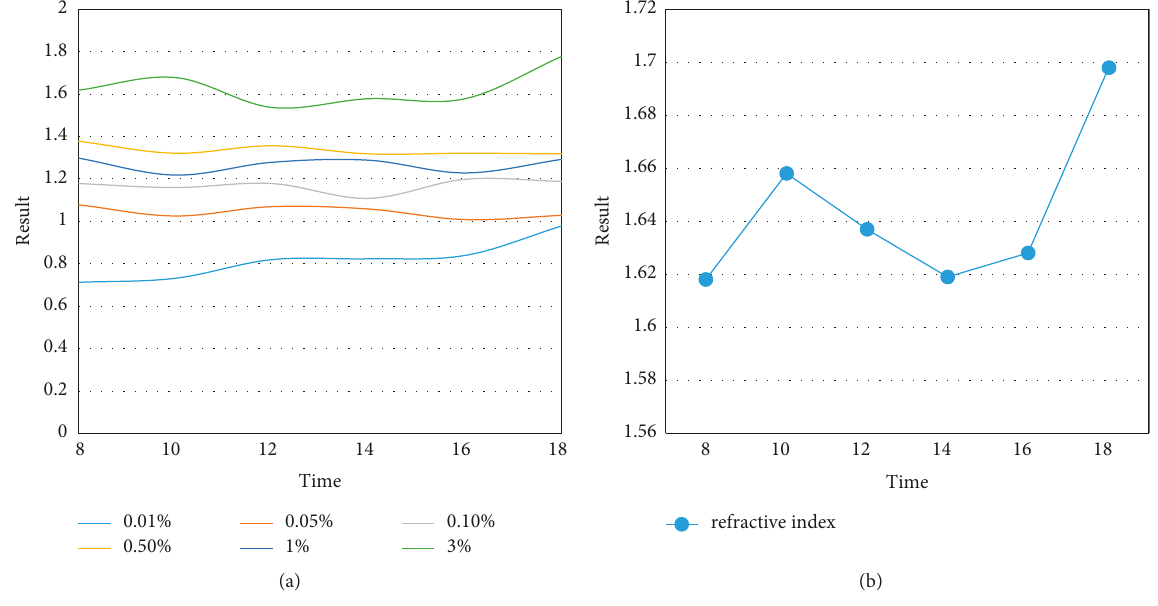
Figure 5: Variation of particle refractive index with time. Table 6: Correlation coefficients of ZnO nanoparticles under different conditions.